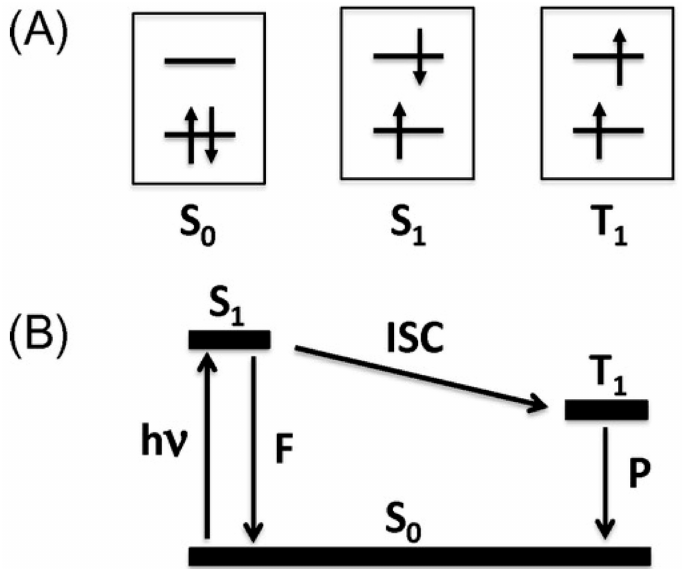
Figure 1. ( A ) Electron configurations of a singlet ground state (S 0 ), a singlet excited state (S 1 ),andatriplet excitedstate(T 1 ). ( B )Jablonskidiagramforfluorescence(F),intersystemcrossing(ISC),andphosphorescence (P) emissions. h ν designates photoexcitation. Reproduced from Ref. [4] with permission. Copyright 2018, The Chemical Society of